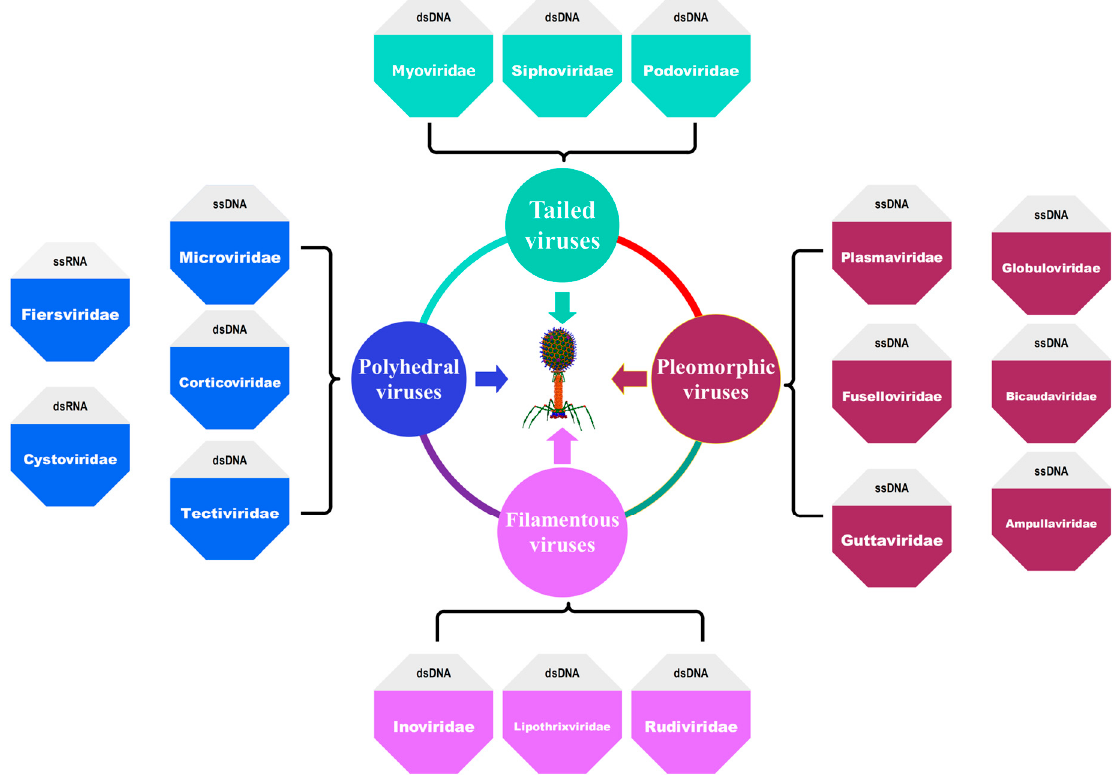
Figure 2. Classification of bacteriophages based on their morphology and nucleic acid content.